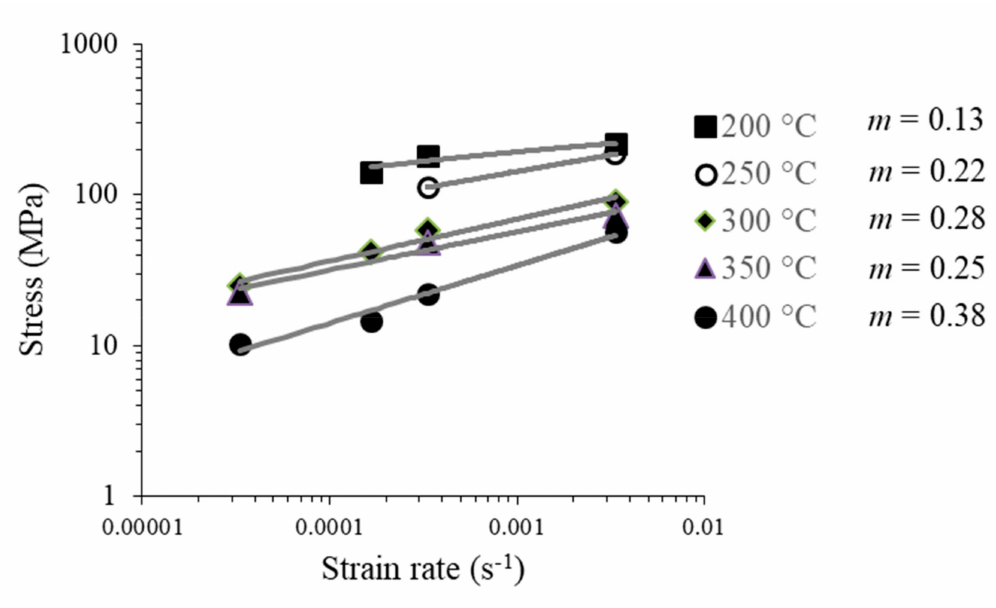
Figure 9. Maximum stress versus strain-rate for di ff erent temperatures and their respective m coe ffi cient for samples processed by one RCS